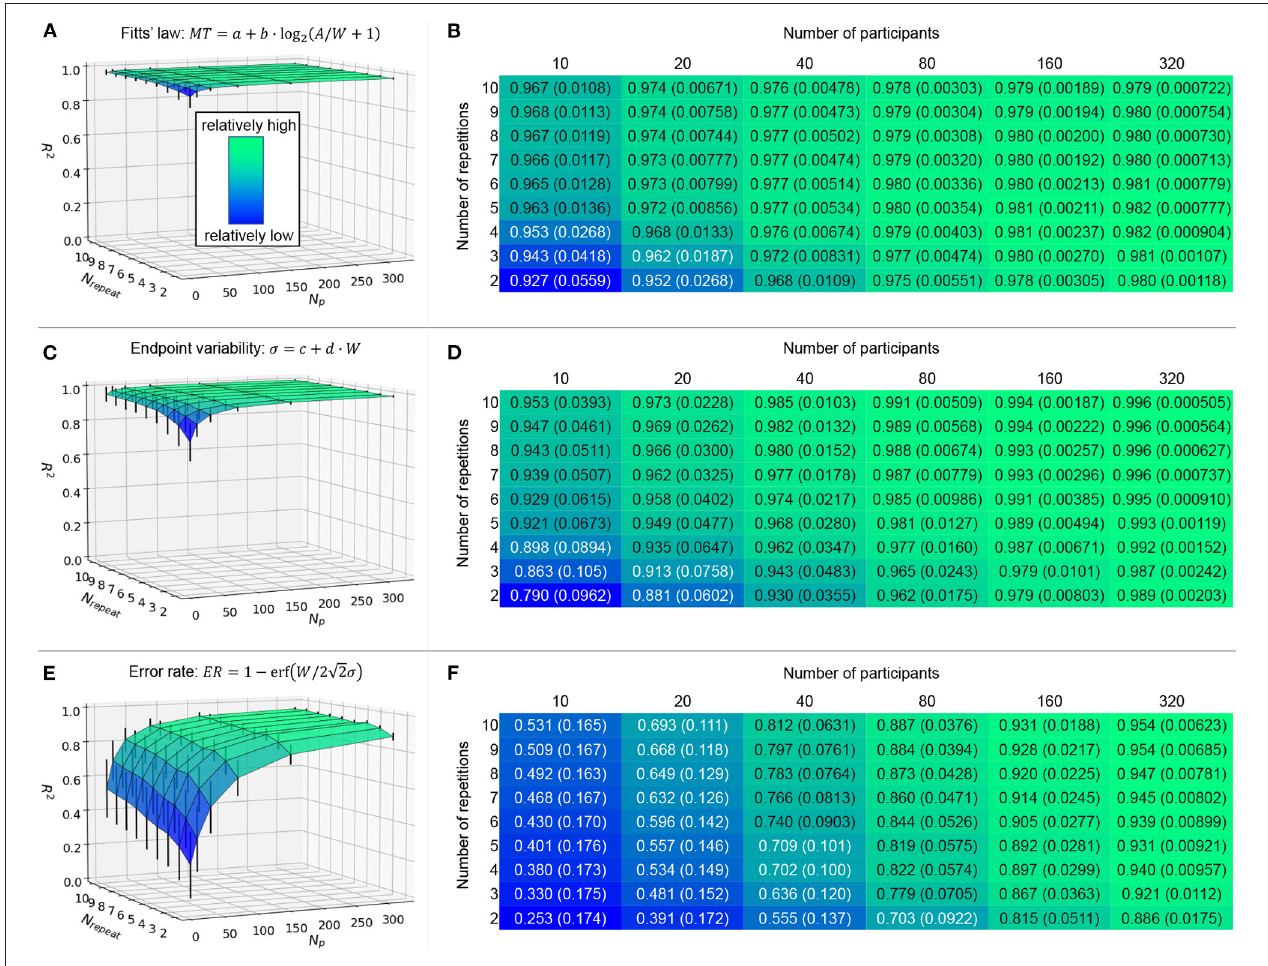
FIGURE 9 | Simulation results on mean (and SD ) model fitness in R 2 by changing N P and N repeat over 1,000 iterations. Error bars indicate 1 SD .